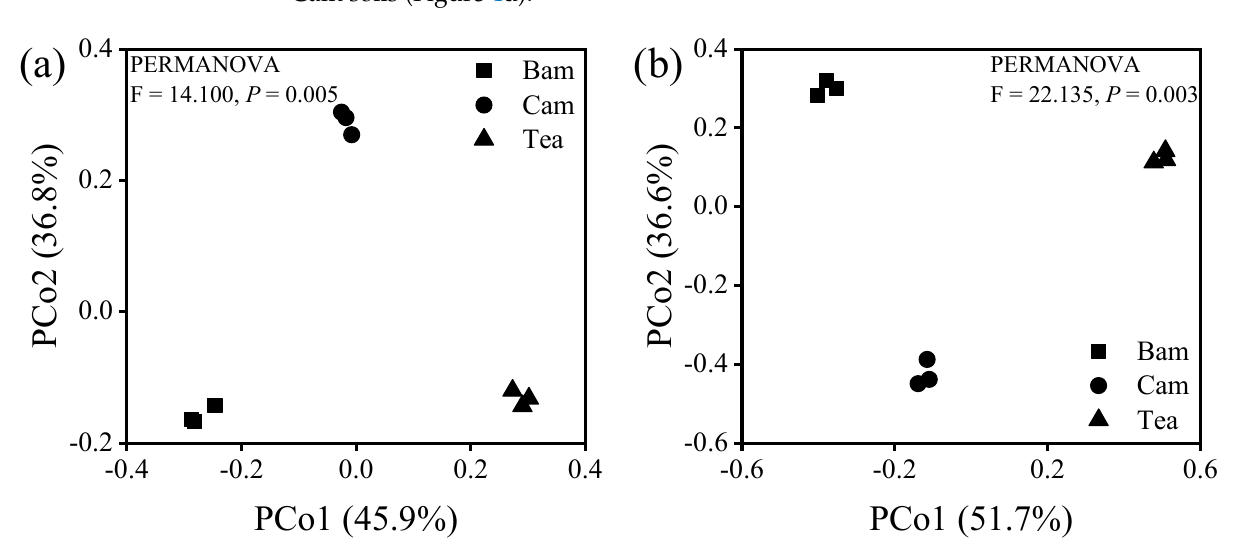
contained significantly higher relative abundances of Basidiomycota than that of Bam and Cam soils (Figure 4d).